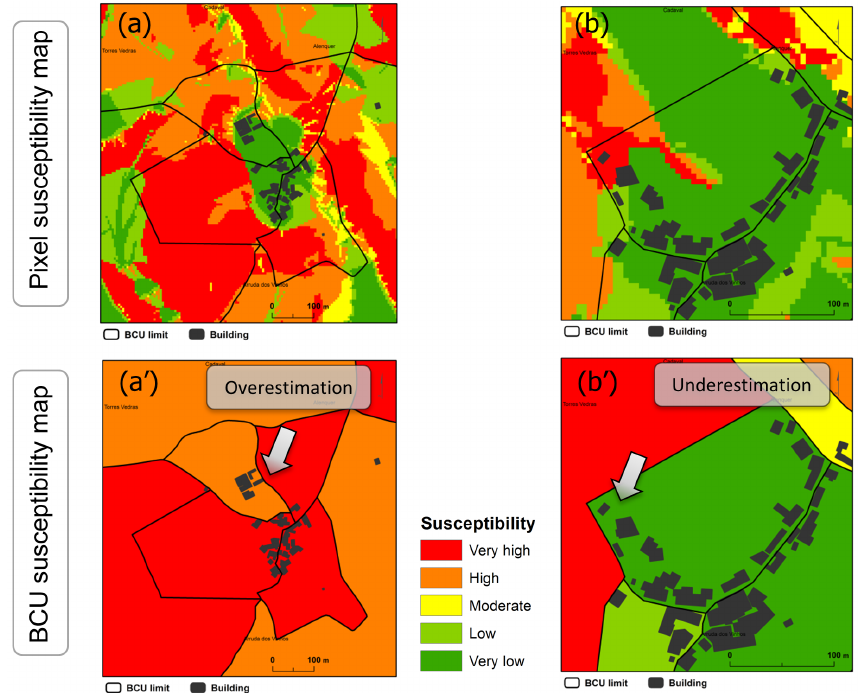
Figure 7. Examples of overestimation and underestimation of exposed buildings in the Alenquer study area considering the BCU suscepti- bility map in comparison with the pixel-based susceptibility